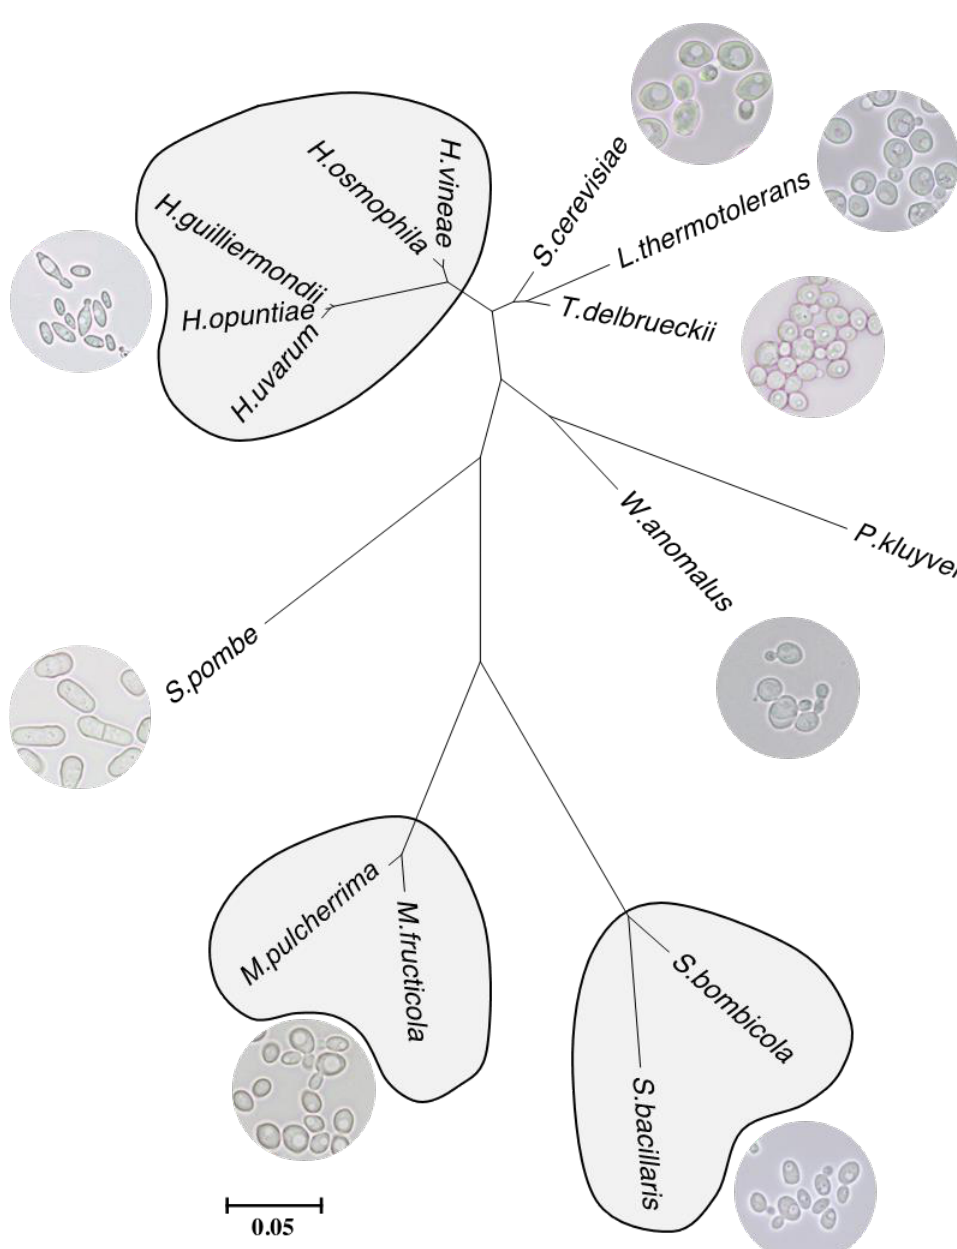
Figure 1. Phylogenetic relationships among wine yeast species based on analysis of D1/D2 LSU rRNA gene sequences. The evolutionary history was inferred by using the Maximum Likelihood method based on the Tamura-Nei model in MEGA7. GenBank accession numbers follow strain numbers: